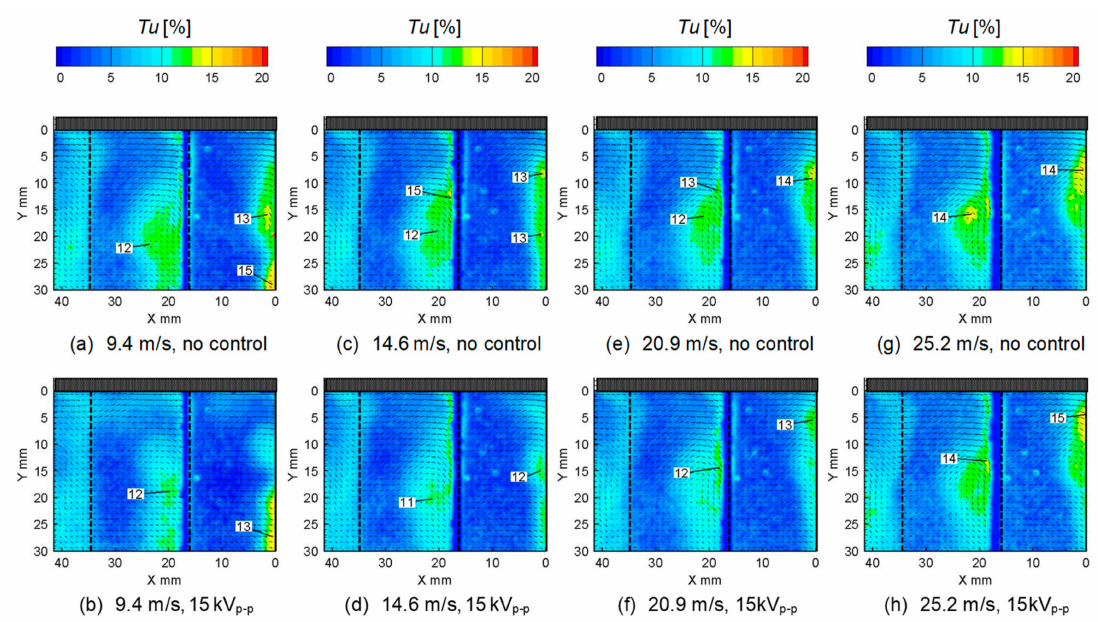
Figure 23. Turbulence intensity distributions at the outlet of the linear turbine cascade at various freestream velocities.